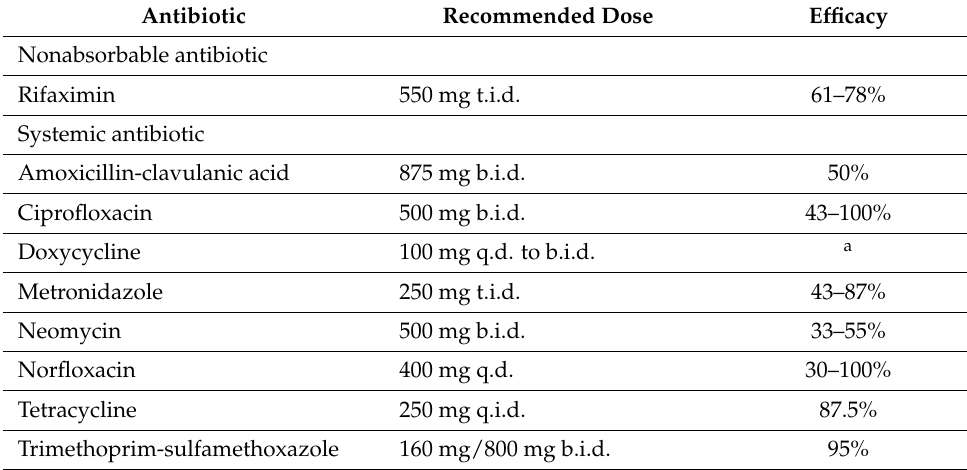
Table 2. Suggested antibiotics for treatment of small intestinal bacterial overgrowth [39]. Reprinted with permission from Ref. [39]. Copyright 2020 Wolters Kluwer Health, Inc.